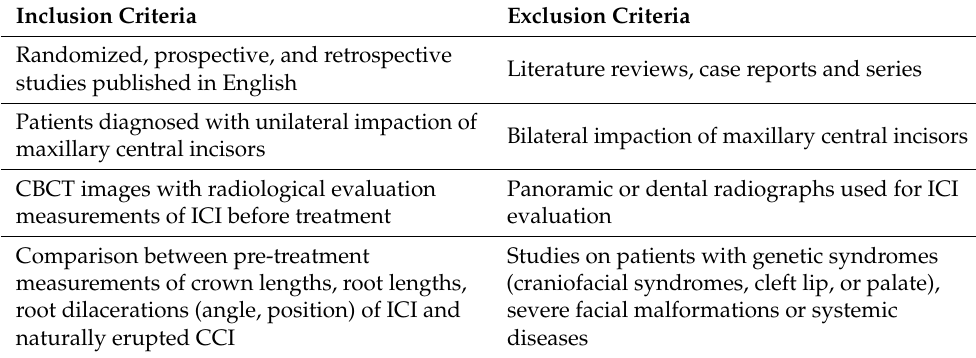
Table 1. Eligibility criteria.